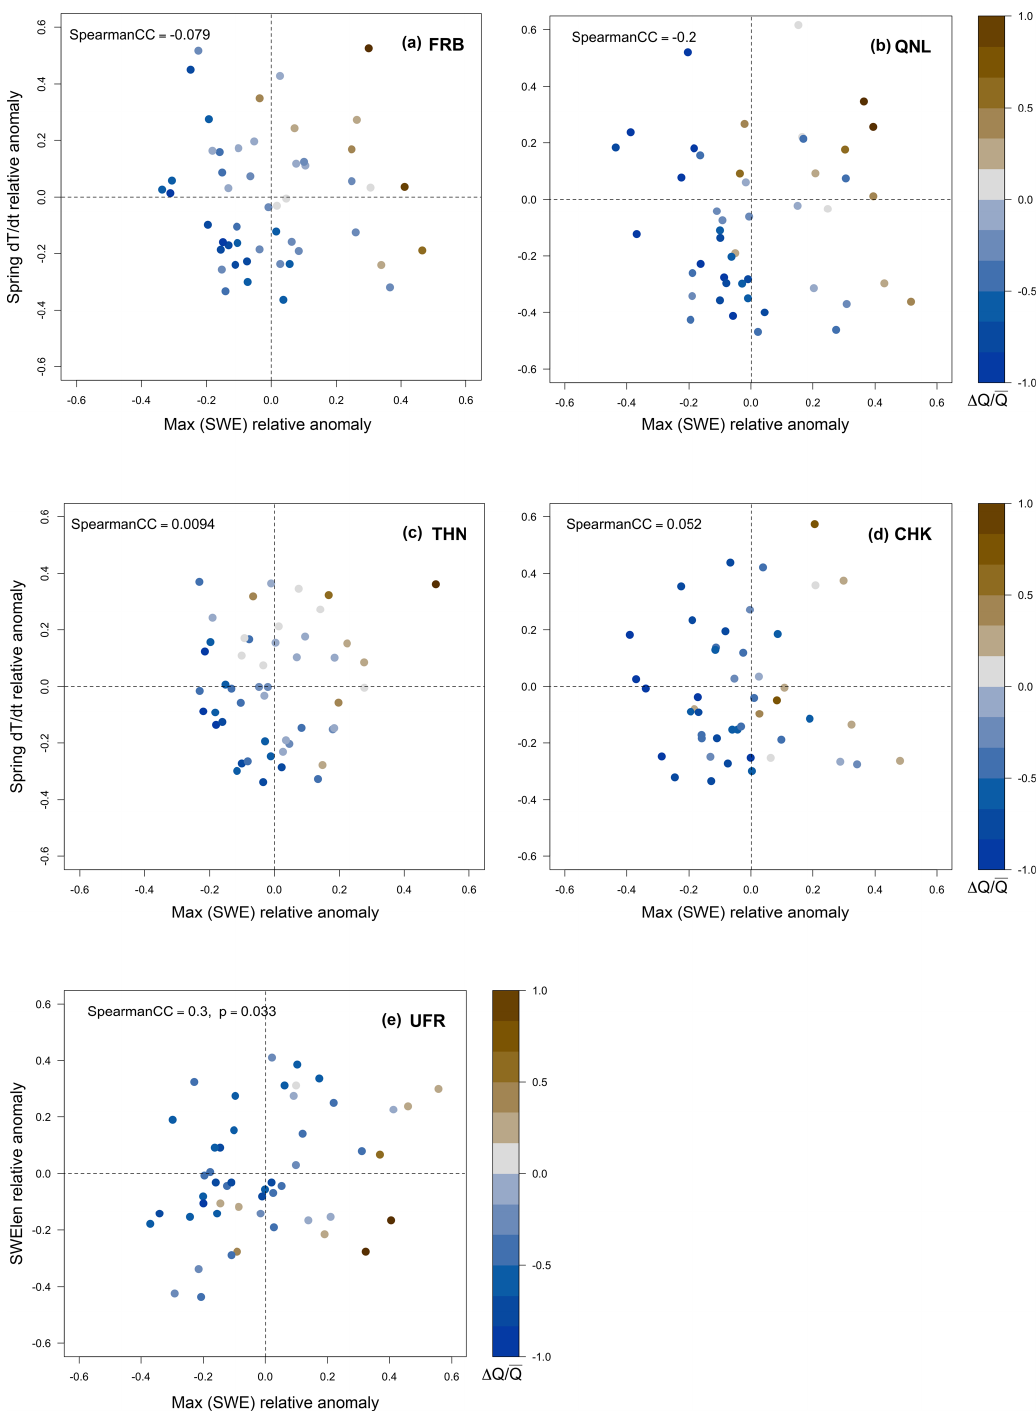
Figure 8. Scatterplots showing the co-dependence of relative APF, (cid:49)Q/Q (colour scale) on the two principal predictors from the MLR analysis ( x - and y -axes), expressed as relative anomalies, in each basin. Counterclockwise from top left: entire Fraser (FRB), Thompson– Nicola (THN), Upper Fraser (UFR), Chilko (CHK) and Quesnel (QNL). The primary predictor in all subbasins is SWE max , while the secondary predictor is d T/ d t in all subbasins except UFR, where it is SWE len . The Spearman rank correlation between the two predictors is shown at upper left in each panel; other than in UFR, none are significant at the 10% ( p < 0.1)